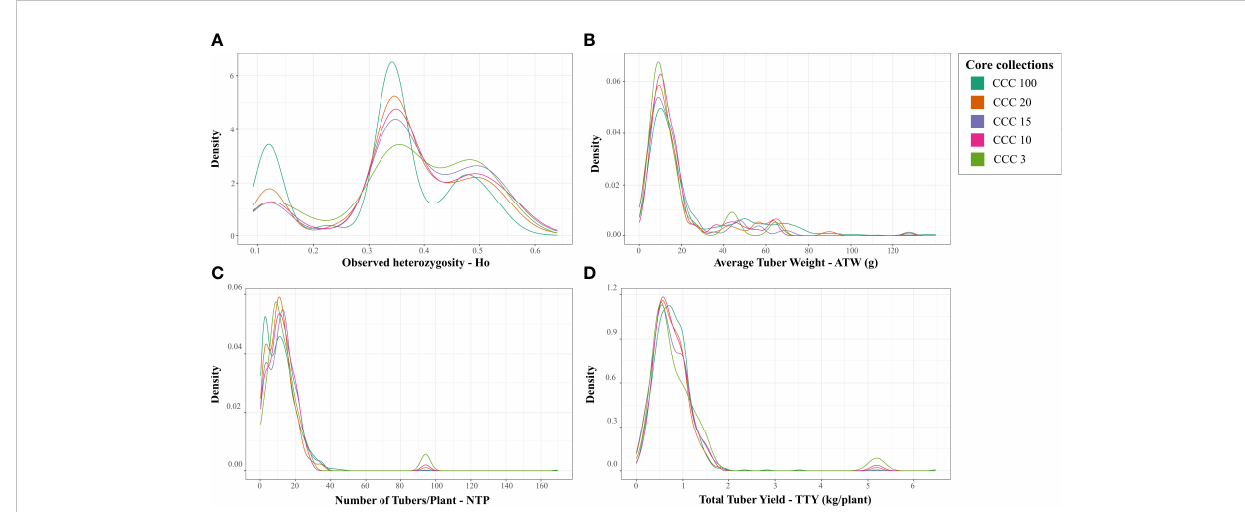
FIGURE 6 Density distribution of the genetic diversity and three different agronomic traits values of samples compared across main and proposed core and mini-core collections for the Colombian Central Collection (CCC) of potatoes. Distribution of values for (A) observed heterozygosity (Ho), (B) Average Tuber Weight in g (ATW), (C) Number of Tubers per Plant (NTP), and (D) Total Tuber Yield in kg/plant (TTY) for the whole CCC (CCC_100), and three core collection sizes of 20 percent (CCC_20), 15 percent (CCC_15), and 10 percent (CCC_10), and one mini-core collection size of 3 percent (CCC_3).